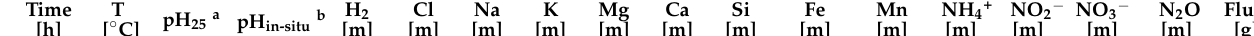
Table 1. Concentration of selected species measured in fluids from experiments in the komatiite–H 2 O–NO 3 − system. Time [h]